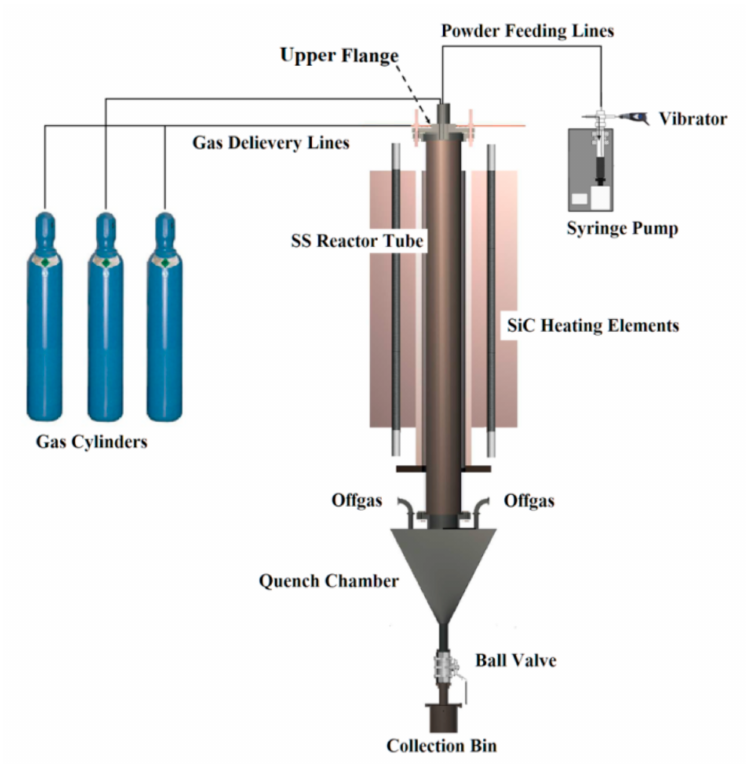
Figure 6. Schematic diagram of the laboratory flash reactor. (The figure is adapted from Sohn et al. [31]).